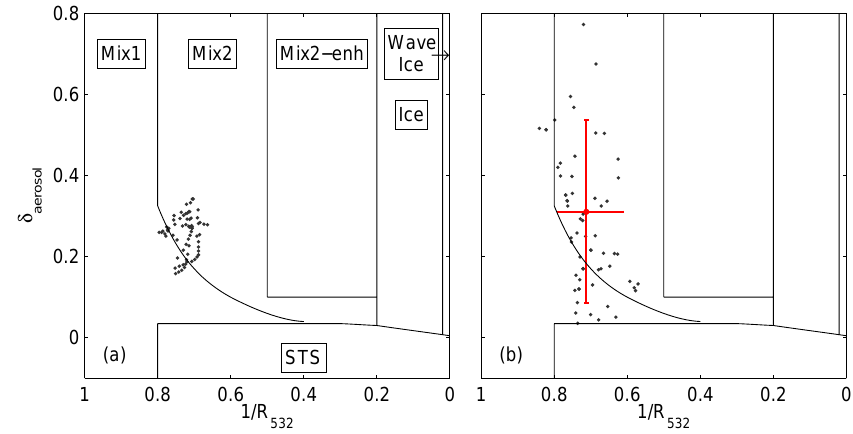
Fig. 4. Modelled aerosol depolarisation ratio ( δ aerosol ) vs. inverse backscatter ratio (1/ R 532 ) without (panel a ) and with (panel b ) consideration of instrument noise, for the mixed NAT/liquid cloud observed on the third CALIPSO overpass of the Arctic vortex on 21 December (denoted here as orbit 21_03). The error bars illustrate one standard deviation of the uncertainty for a single point. The different areas of the plots correspond to the PSC classifications described in Sect.